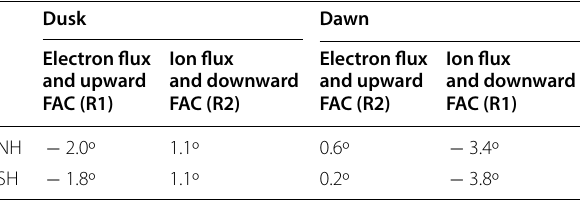
Table 2 The mean differences between the peaks of electron/ion energy flux and upward/downward FACs separately for dusk and dawn sides and two hemispheres.